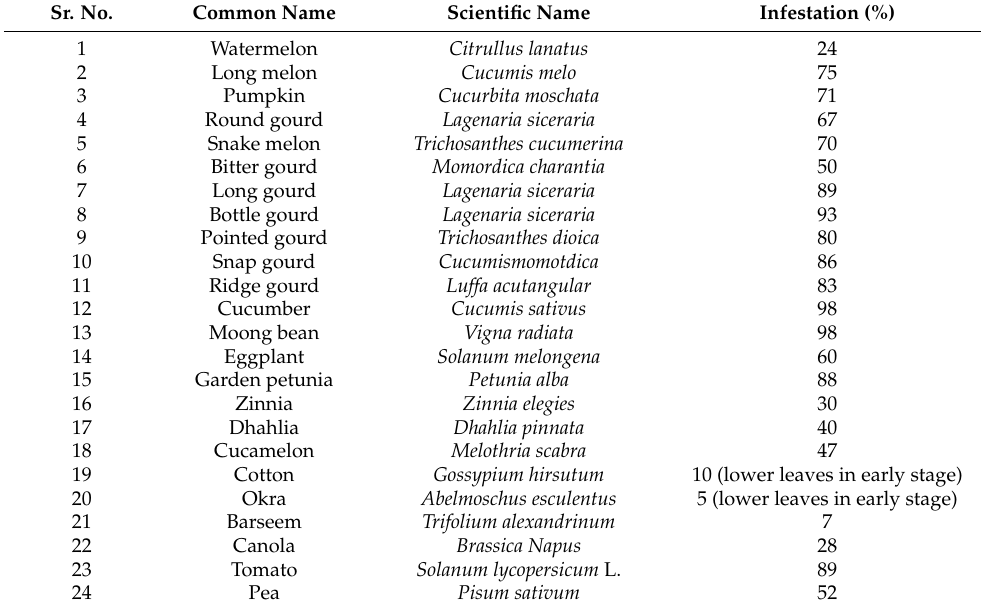
Table 3. List of plant species infested by vegetable leaf miner ( Liriomyza spp.) (2021–2022). Sr.